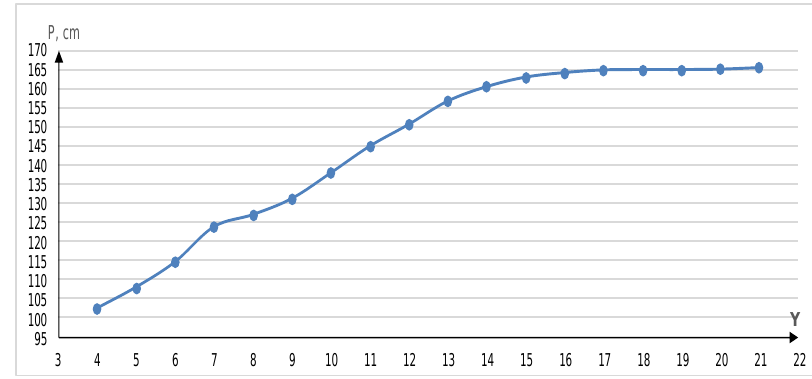
Fig. 1. Dynamic of P (height, cm) indicators’ changes from Y (age, years)